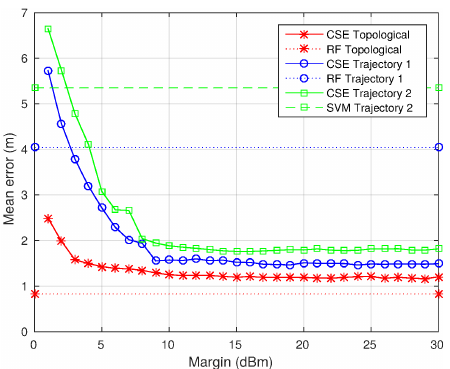
Figure 11. Mean error evolution changing the noise margin used to create the localization subsurfaces.